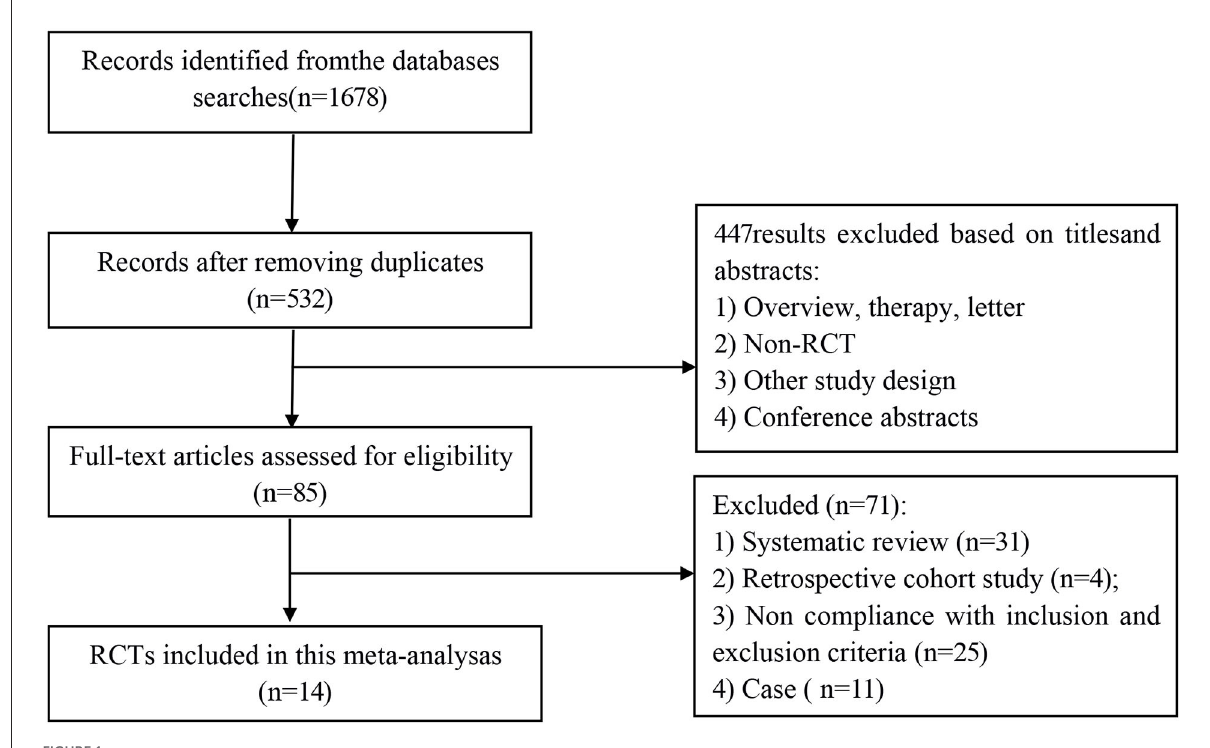
FIGURE1 Flowchart of included